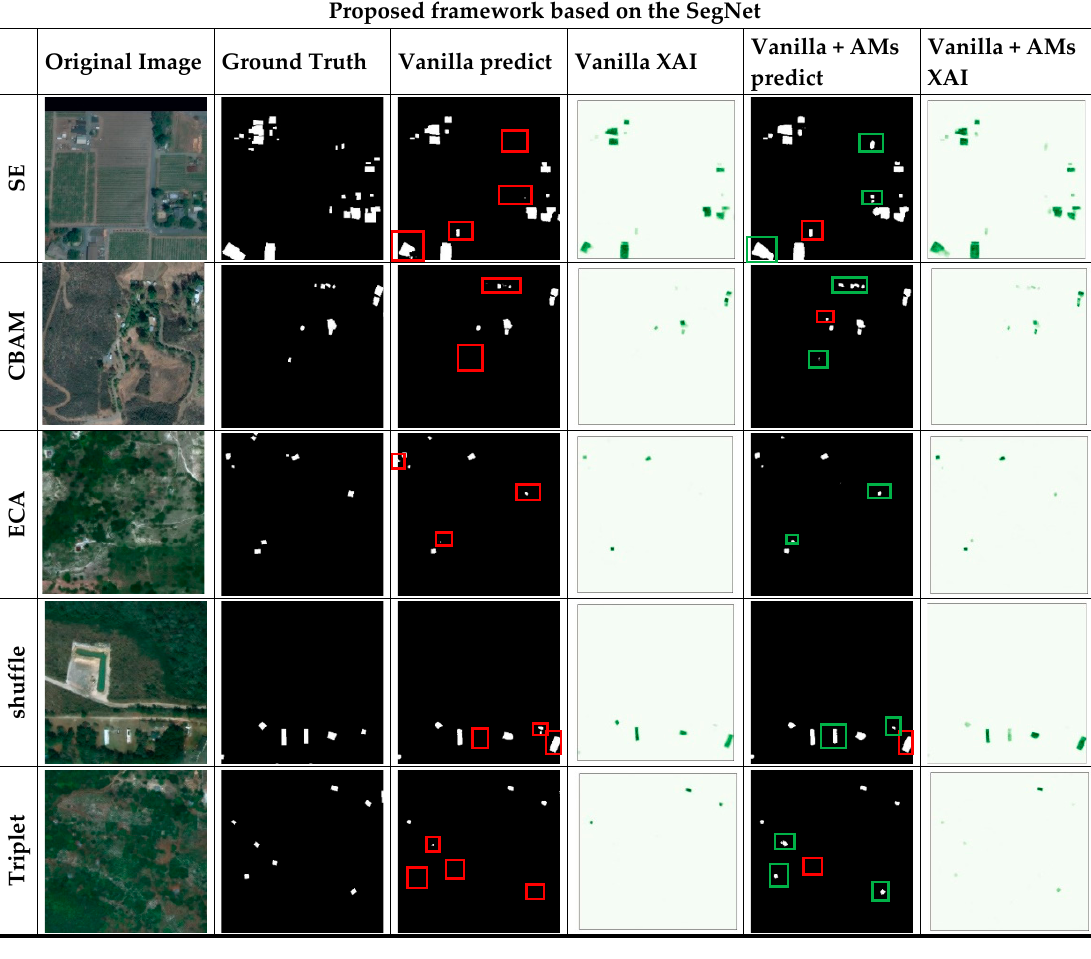
Figure 6. Visualization of predicted labels for vanilla SegNet and attention-based SegNet and LayerDeepLIFT (red box: missed building and wrongly labeled building, green box: true building). In XAI outputs, related objects should be green and bolder than other objects.